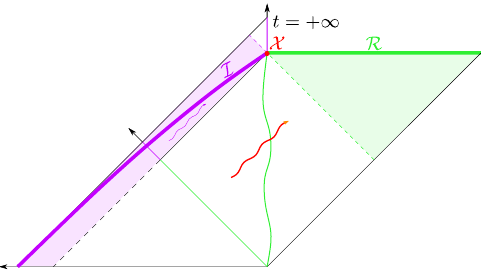
Figure 3 . The final island. The island eventually ends up at the same location as the observer on the boundary. There is no BH anymore, a full Cauchy slice is given by I ∪ R . At this point, the observer has caught all the outgoing radiation and can construct the interior (in